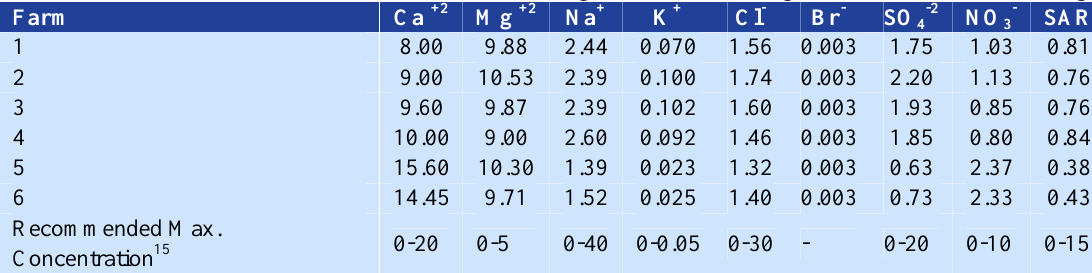
Table 2. Cations and anions concentrations in the irrigation waters of vegetable farms in terms of mg l -1 Farm